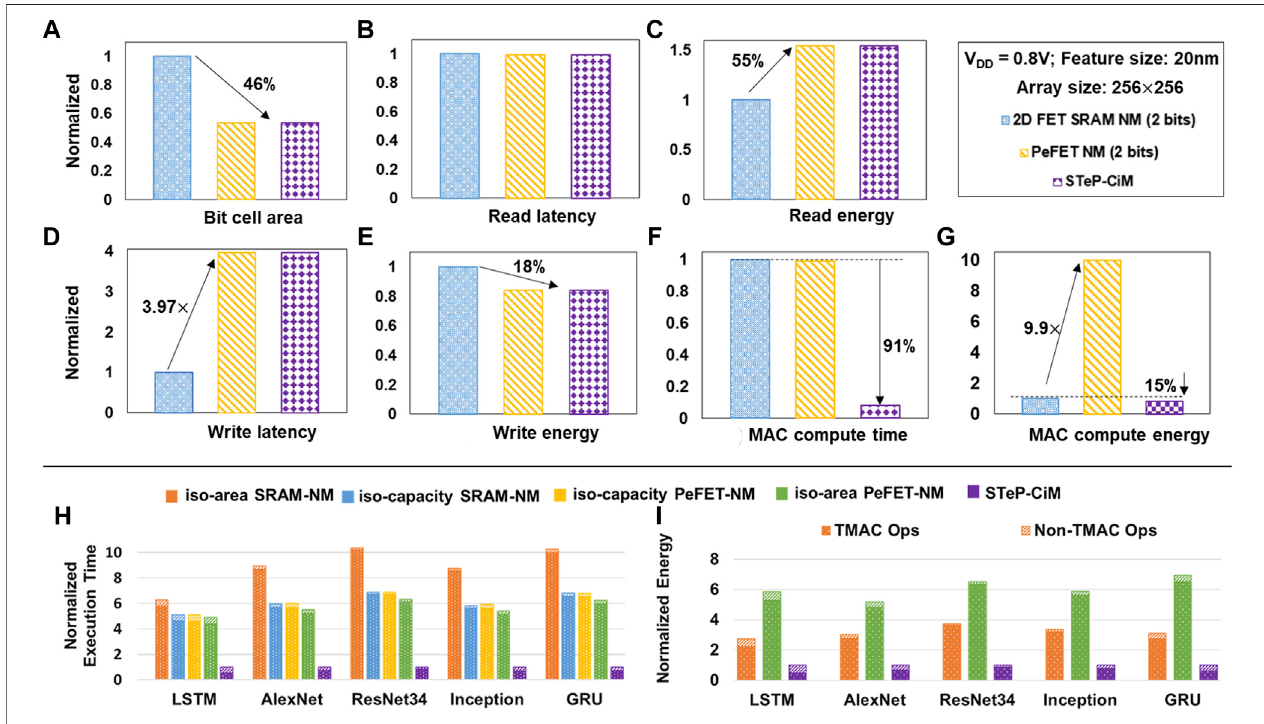
FIGURE11| Array-levelresultsofSTeP-CiMvs.PeFET-NMandSRAM-NMshownfor (A) bitcellarea, (B) readlatency, (C) readenergy, (D) writelatency, (E) write energy, (F) MACcomputetime,and (G) MACcomputeenergy.System-levelresultsfor (H) normalizedexecutiontime. (I) NormalizedenergyofSTeP-CiMwithrespectto iso -capacity and iso -area PeFET-NM and